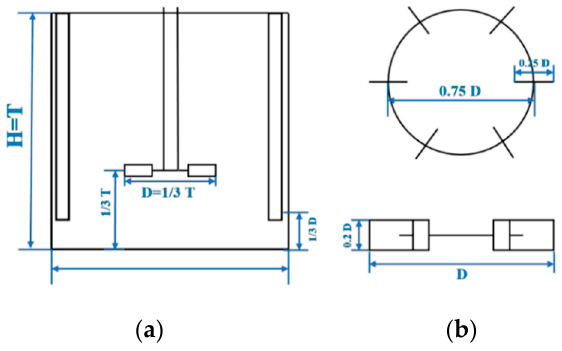
Figure 1. View of ( a ) the stirred tank and ( b ) the Rushton turbine.